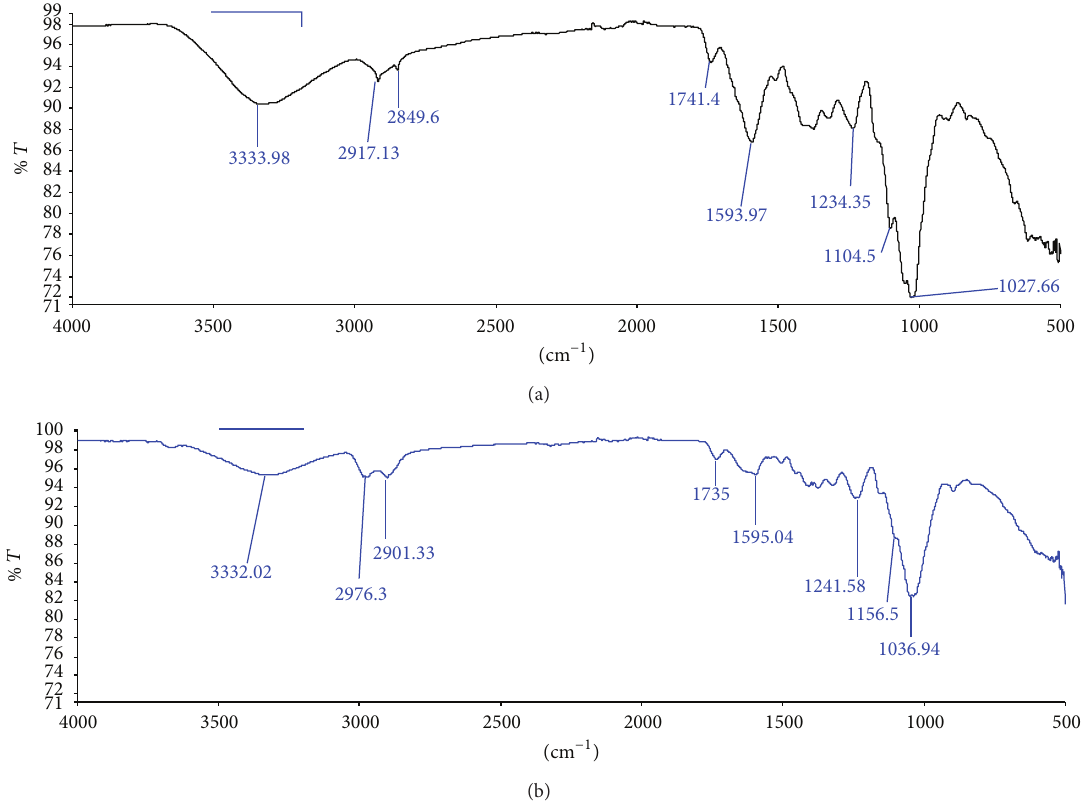
Figure 3: Unnormalized spectra of MSP (a) before metal ion removal and (b) after metal ion